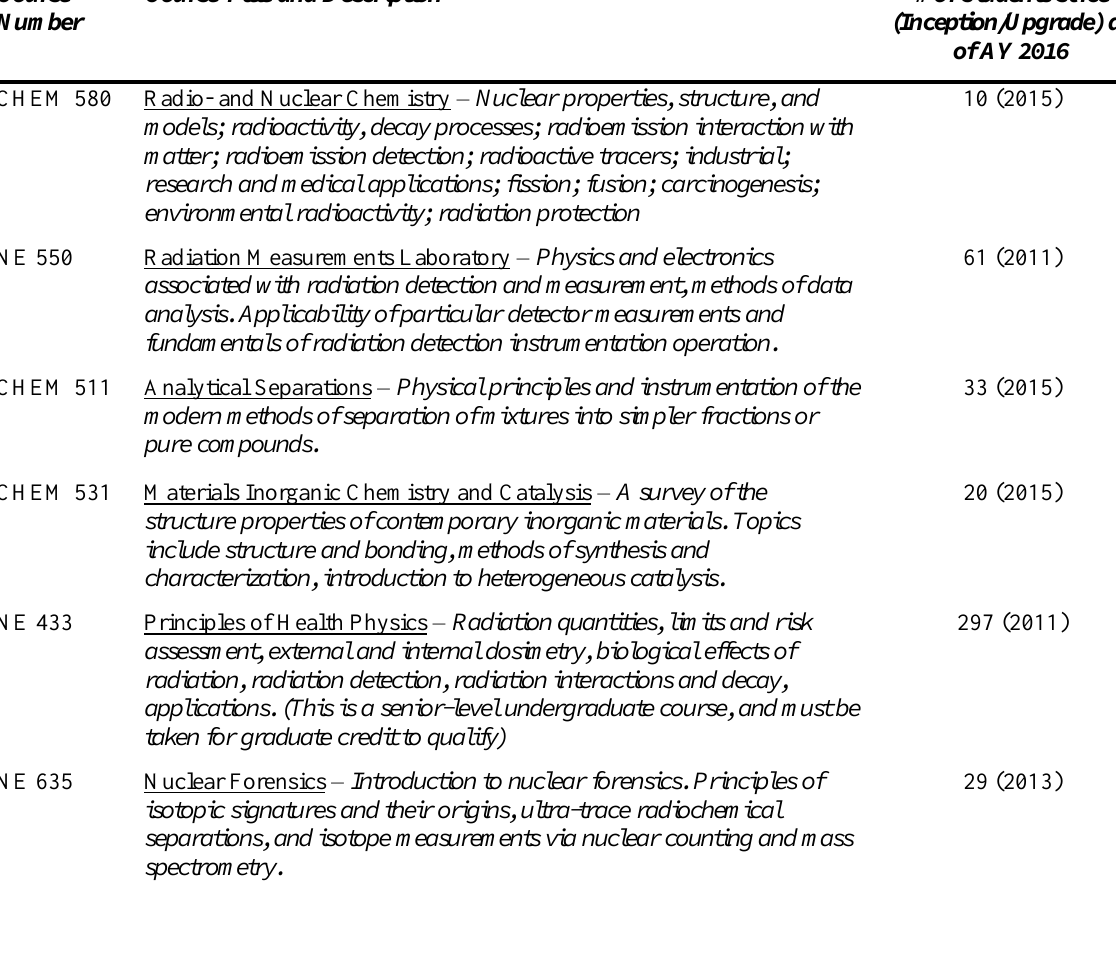
Table 3. Chemistry and nuclear engineering courses available to fulfill the Radiochemistry Graduate